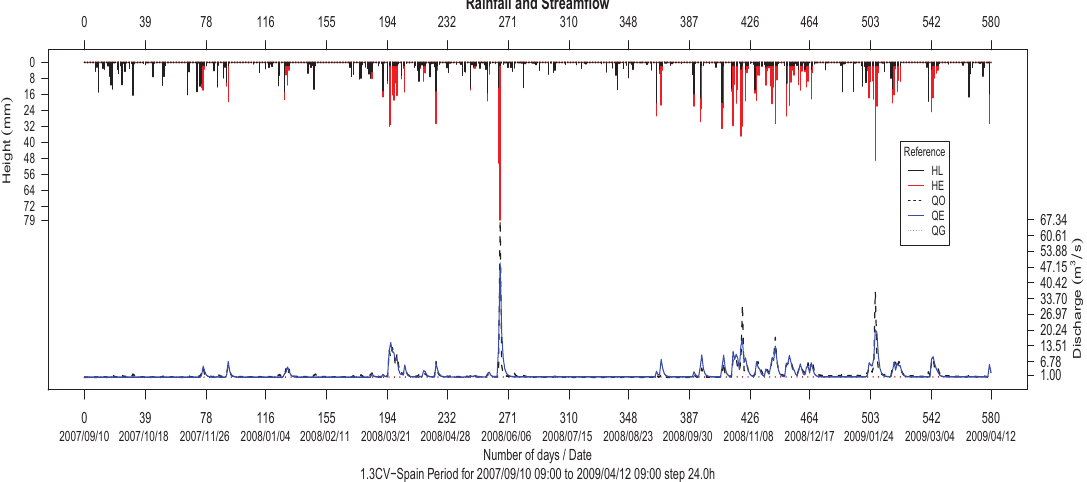
Figure 9. Hyetograph and Hydrograph from validation data series 1.3CV of Asua basin, Bizkaia,